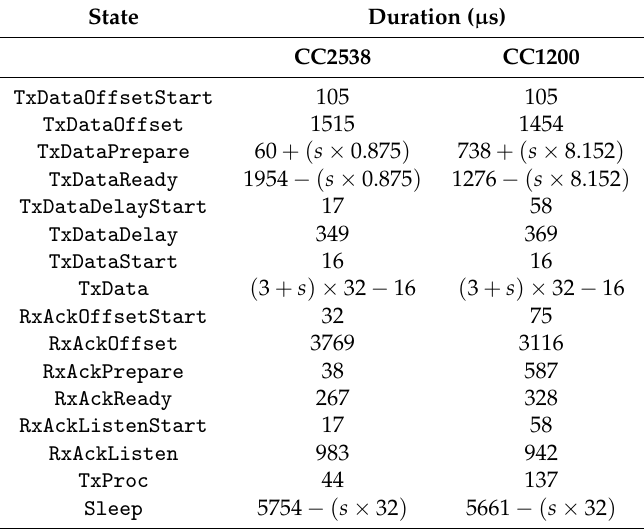
Table 14. State durations in the TxDataRxNoAck time slot with a total length of 15ms and s being the packet size in